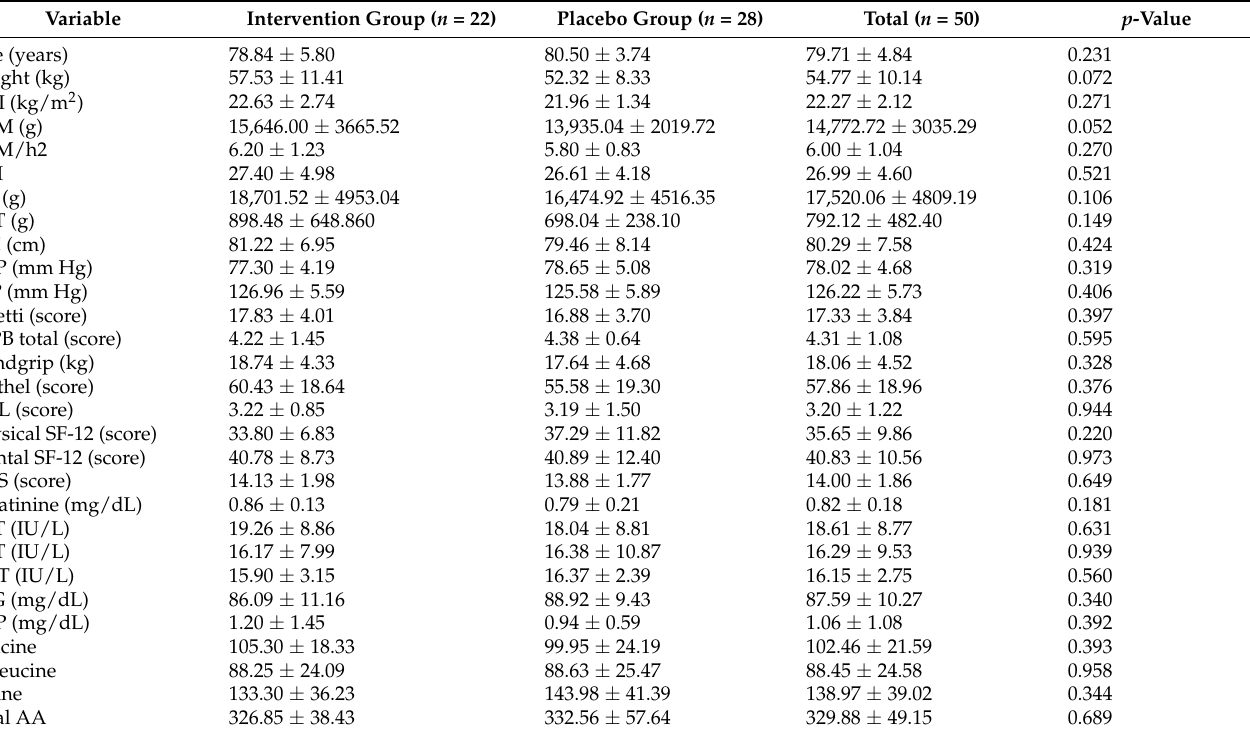
Table 1. The baseline clinical characteristics of patients between the intervention and placebo